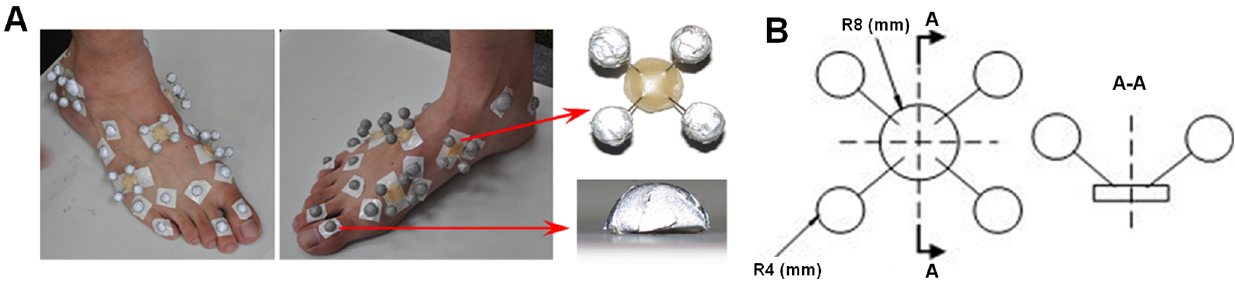
Figure 2. The infrared marker cluster system used in this study to capture 3D foot motions. (A)The foot was divided into five segments including hindfoot, midfoot, medial and lateral forefoot and toes. A set of thermal plastic plates, each carrying four infrared markers was mounted firmly on each segment to capture the segmental motions. A number of hemispherical infrared markers were also attached on the anatomical landmarks. (B) The configuration of the rigid marker cluster and the hemispherical